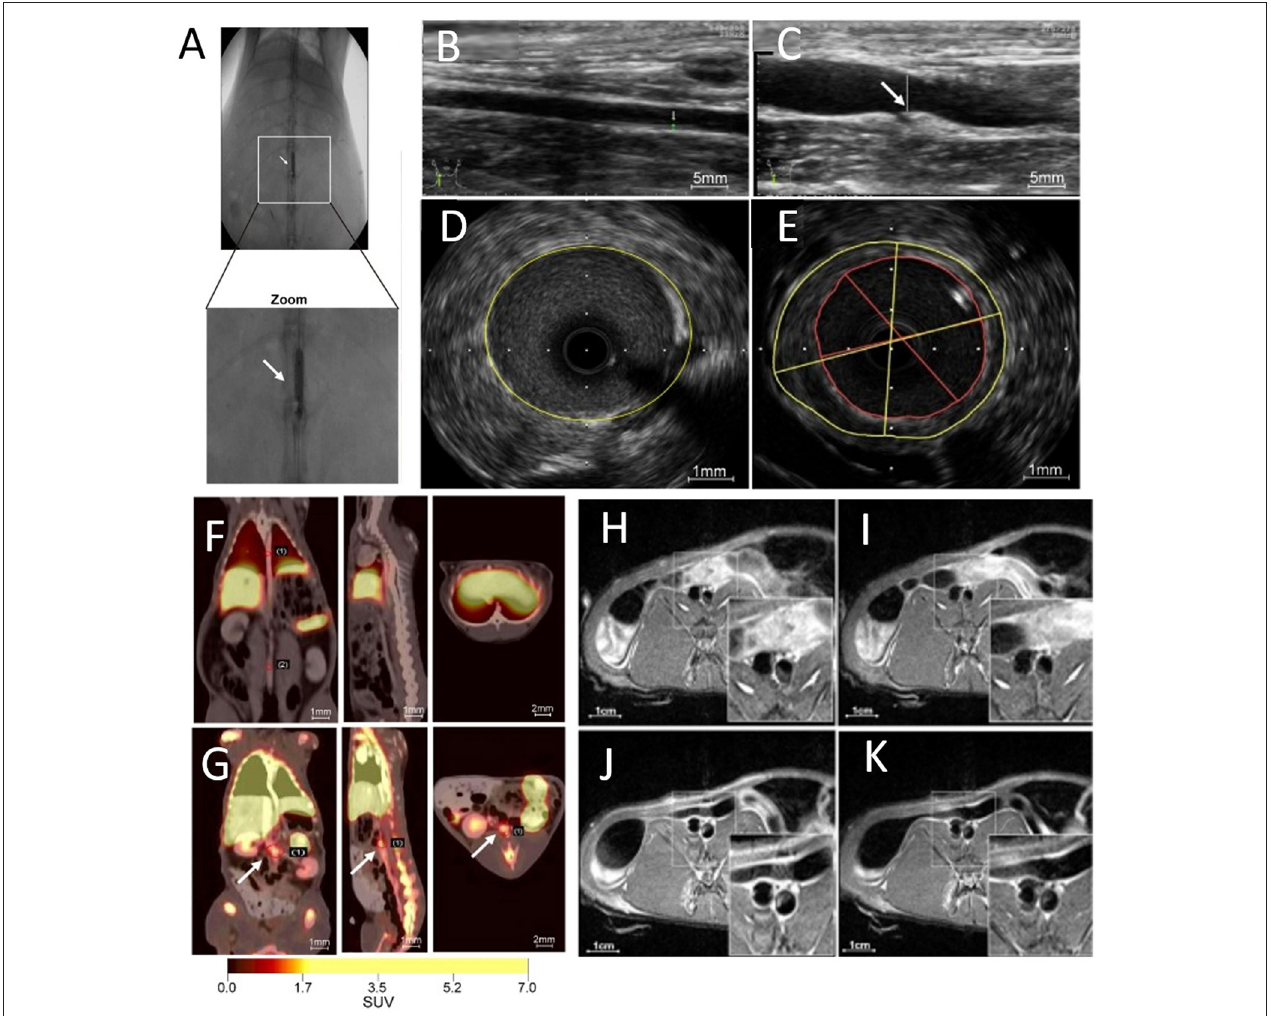
FIGURE 7 | Multimodal imaging of angiogenesis. (A) Abdominal aorta balloon denudation model, showing ultrasonic images of (B) control vessels and (C) vessels after denudation injury displaying vessel enlargement and plaque formation 8 weeks after injury. Representative intravascular ultrasonic images of (D) control and (E) injured vessels, showing a greater plaque burden and plaque eccentricity in the injured mice. PET images of rabbits 2h after (F) 68 Ga-NGD-MNPs or (G) 68 Ga-NUD-MNPs injection. MR images of abdominal aorta before and 4h after (H,I) control NUD-MNPs injection or (J,K) GEBP11 peptide targeted NGD-MNPs injection [Scale bar (H-K) − 1cm; adopted from (95) with pending permission]. 68 Ga-NUD-MNPs, 68 Ga-NOTA-unrelated peptide-DMSA-MNPs; 68 Ga-NGD-MNPs, 68 Ga-NOTA-GEBP11-DMSA-MNPs; DMSA-MNPs, 2, 3-dimercaptosuccinnic acid-coated paramagnetic nanoparticles; NOTA, 1,4,7-triazacyclononane-N,N’,N”-triacetic acid; GEBP11, peptide with angiogenic affinity.